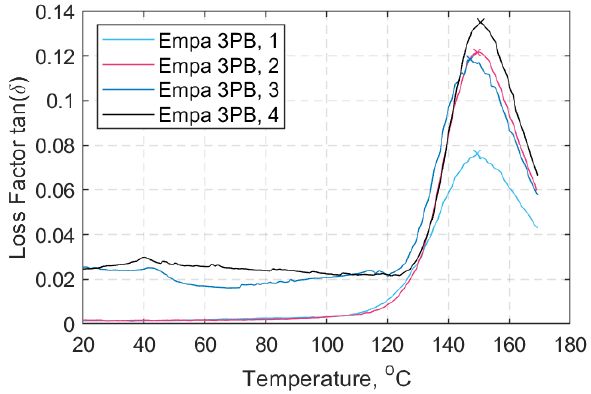
Figure 7. Loss factor tan δ over temperature (°C)—all dynamic mechanical thermal analysis (DMTA) samples.